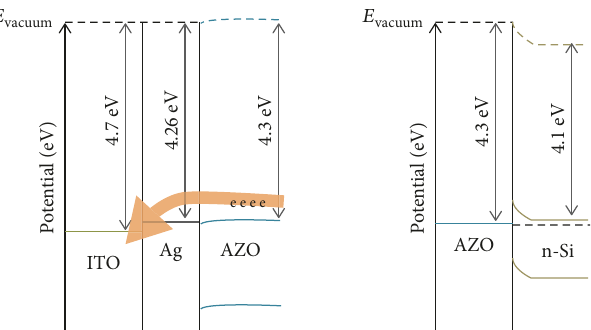
Figure 6: Band diagram of ITO/Ag/AZO/n-Si device.